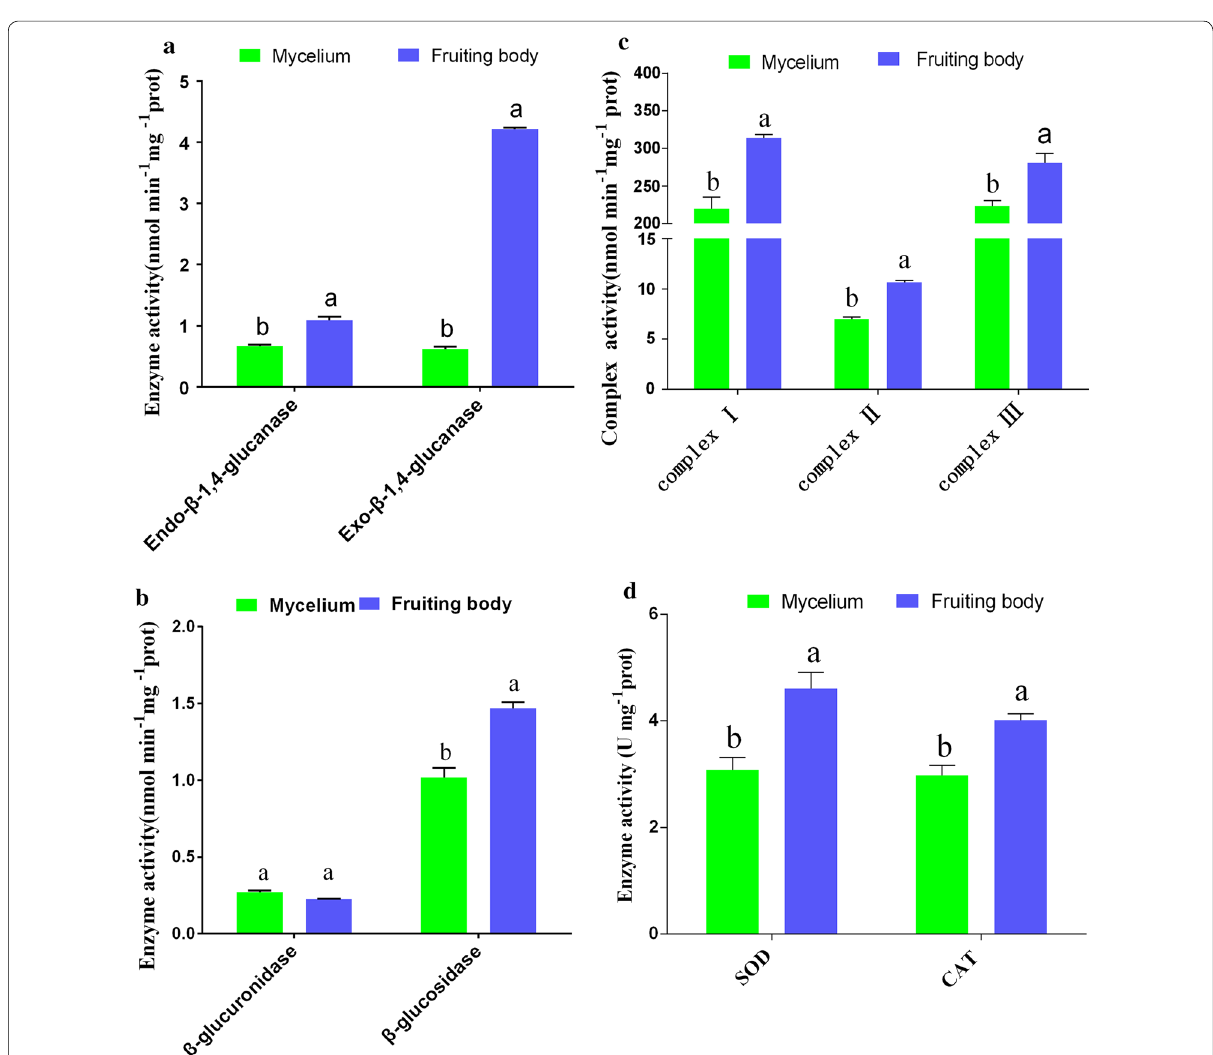
Fig. 3 Histogram showing the enzyme activity of CAZymes, oxidoreductases and mitochondrial complex proteins. a , b Cellulase activities of exo-β-1,4-glucanase, endo-β-1,4-glucanase, β-glucosidase and β-glucuronidase. c Oxidoreductase activities of SOD and CAT. d Mitochondrial complex enzyme activities of complexes I, II, and III. All data are presented as the means letters on the bars denote statistically significant differences compared with the enzyme activity in the mycelium according to multiple comparisons testing (P <